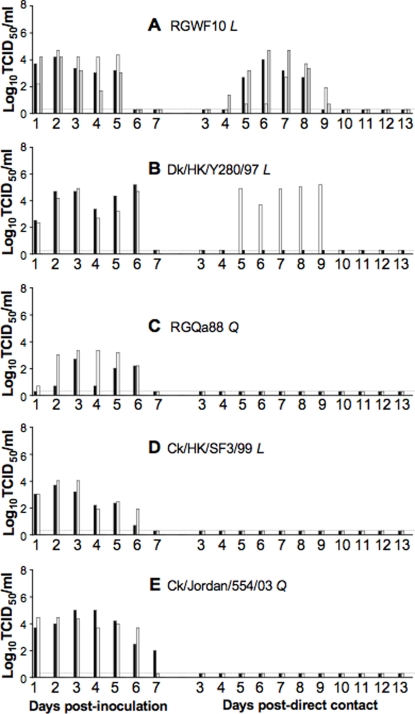
Replication and direct contact transmission of H9N2 viruses.Ferrets were inoculated intranasally (i.n.) with 106 TCID50 of H9N2 viruses RGWF10 (A), Dk/HK/Y280/97 (B), RGQa88 (C), Ck/HK/SF3/99 (D), and Ck/Jordan/554/03 (E). Twenty-four hours later, one naïve ferret (direct contact) was added to the same cage as each of the infected ferrets. Nasal washes were collected daily and were titrated in MDCK cells. Black, white and gray bars represent individual ferrets sampled and the amount of viral shedding at different days pi. The titers are expressed as log10 values of TCID50/ml with the limit of detection at 0.699 log10TCID50/ml. The dotted line was arbitrarily set at <0.3 log10TCID50/ml in order to represent samples below the detection limit. L and Q correspond to Leu226 and Gln226, respectively in the HA RBS.